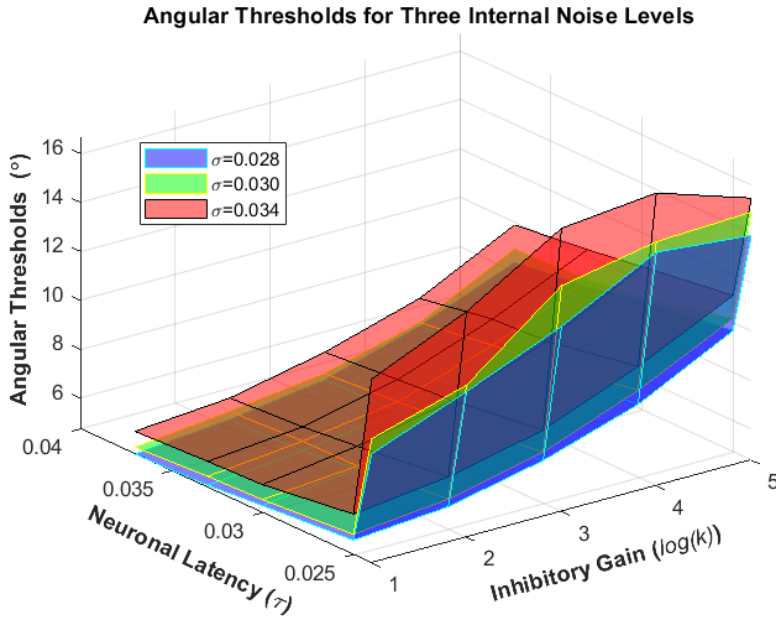
Figure 4. The resulting psychometric function angular thresholds when running the model for exemplary ranges of neuronal latency ( τ = 0.024, 0.025, 0.03, 0.033, 0.037 s) and inhibitory gain ( k = 2, 4, 8, 16, 32) for three noise levels ( δ = 0.028, 0.030,